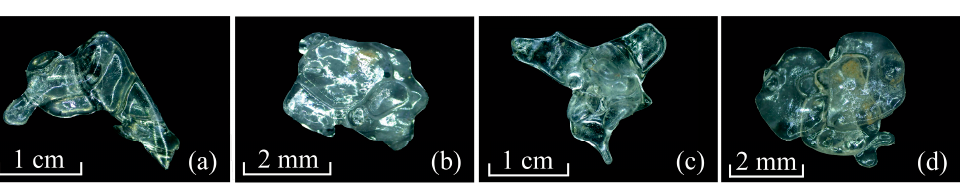
Figure 9. Three frazil particles agglomerated together.